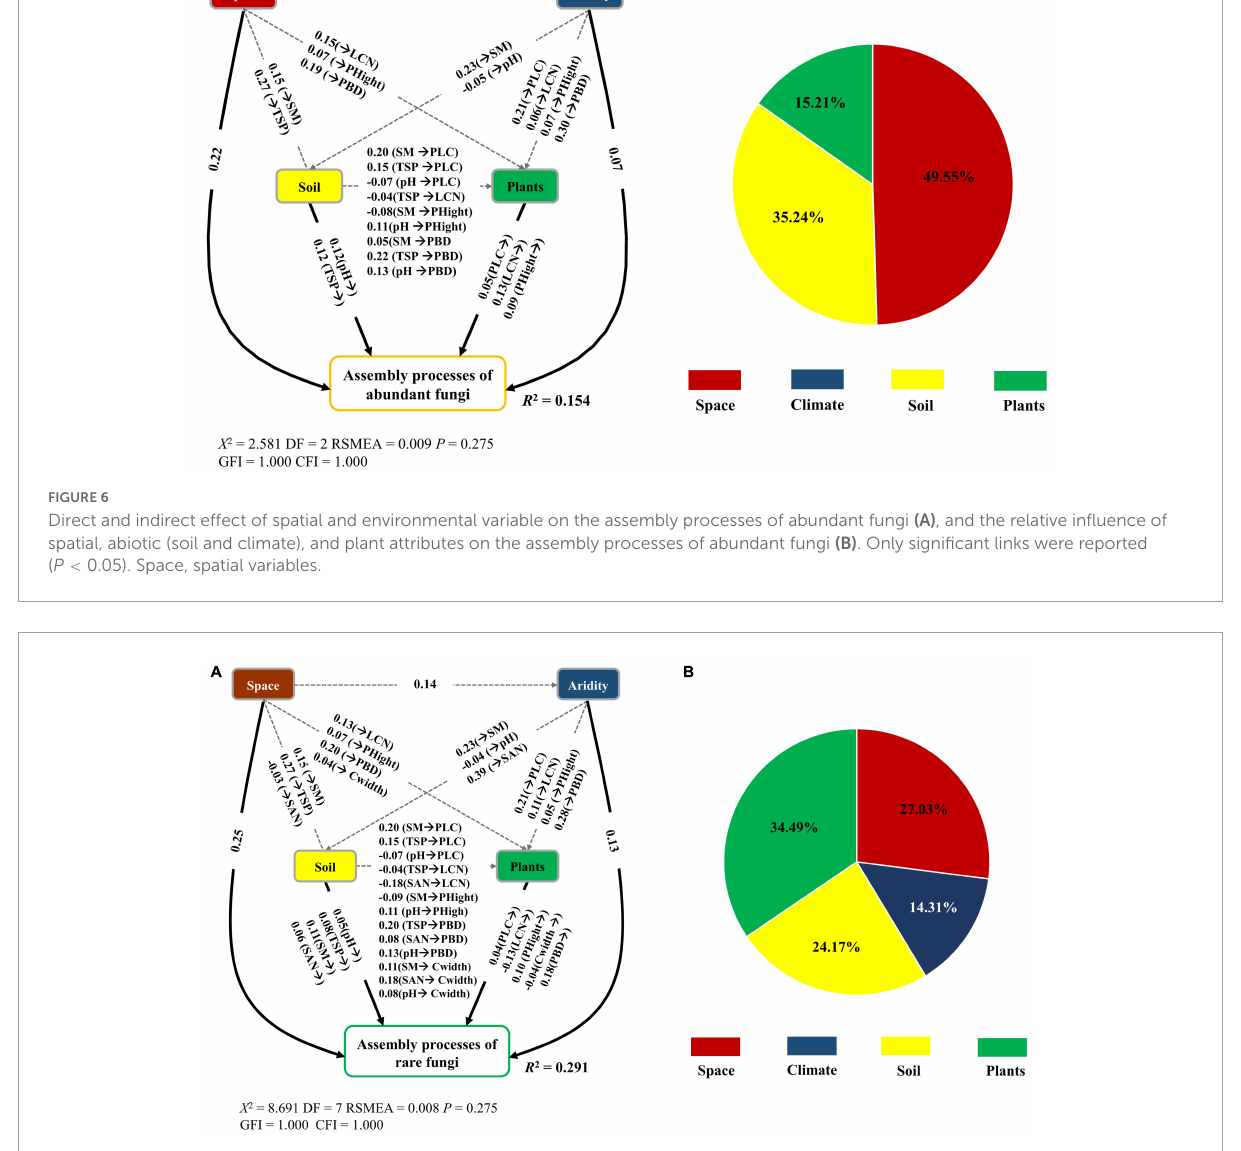
FIGURE7 Direct and indirect effect of spatial and environmental variable on the assembly processes of rare fungi (A) , and the relative influence of spatial, abiotic (soil and climate), and plant attributes on the assembly processes of rare fungi (B) . Only significant links were reported ( P < 0.05). Space, spatial variables; PBD, plant β